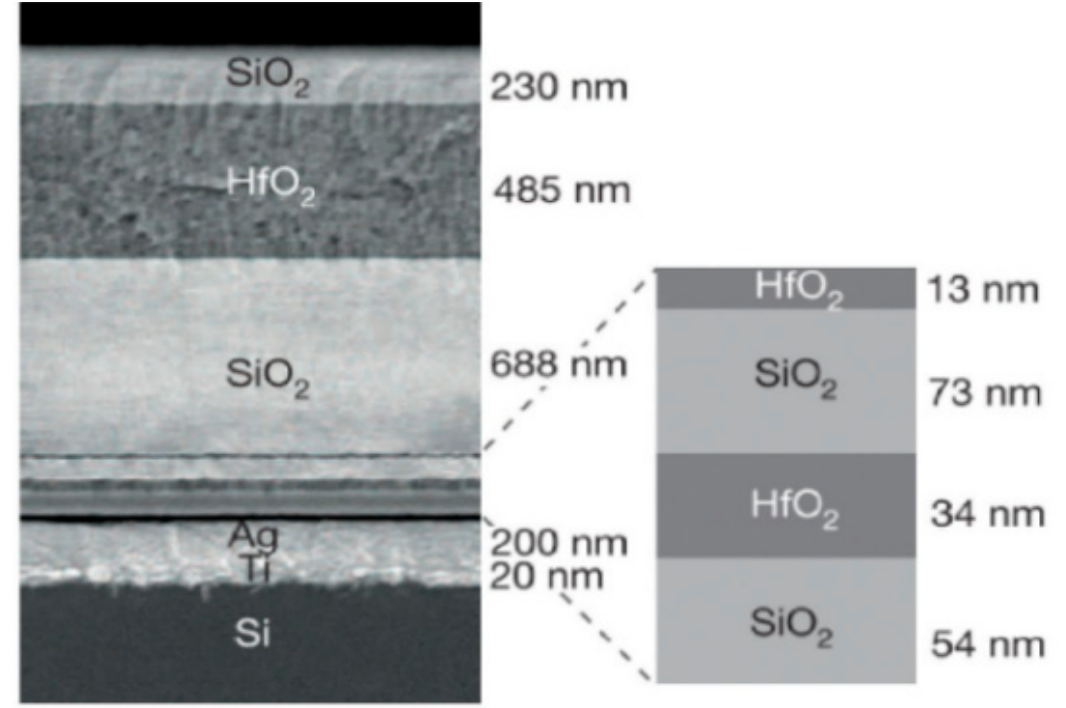
Figure 17. DPRC multilayer structure of SiO